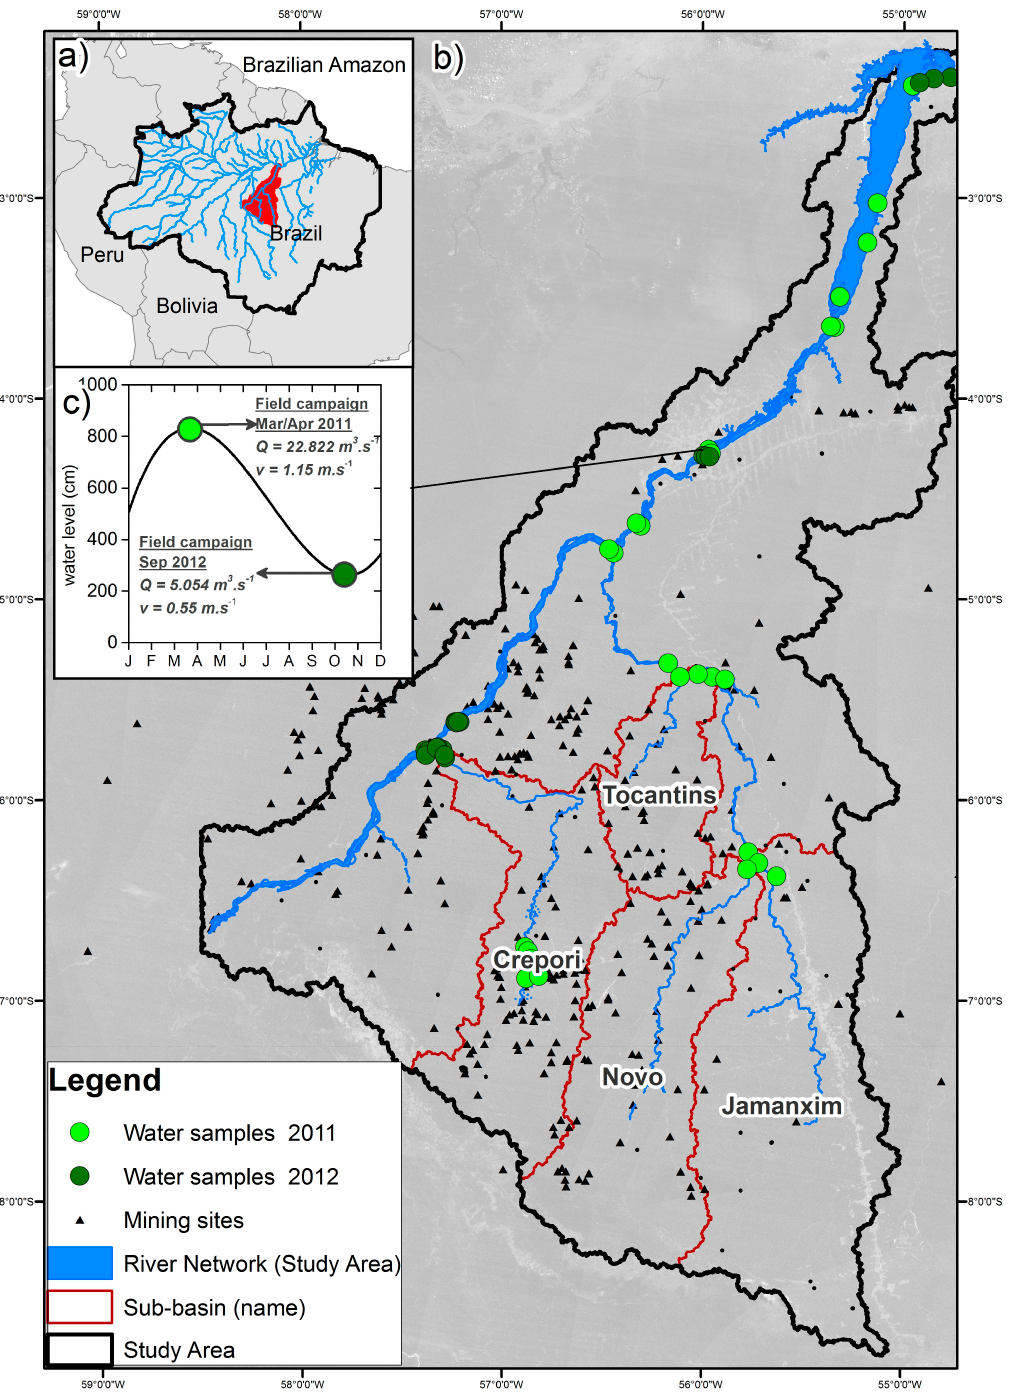
Figure 1. Study area. ( a ) Overview of the Brazilian Amazon. ( b ) Tapajós River Basin in the Brazilian Amazon showing the main tributaries, sample sites (see Section 4.1), deforestation [22] (light grey), and mines [23]. ( c ) Water flow ( Q ) and water speed ( v ) are also shown for the Tapajós River at the Itaituba City region during high and low water level.